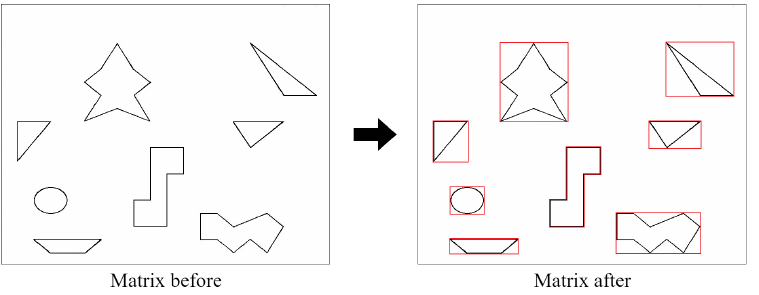
Figure 7. Rasterization of the